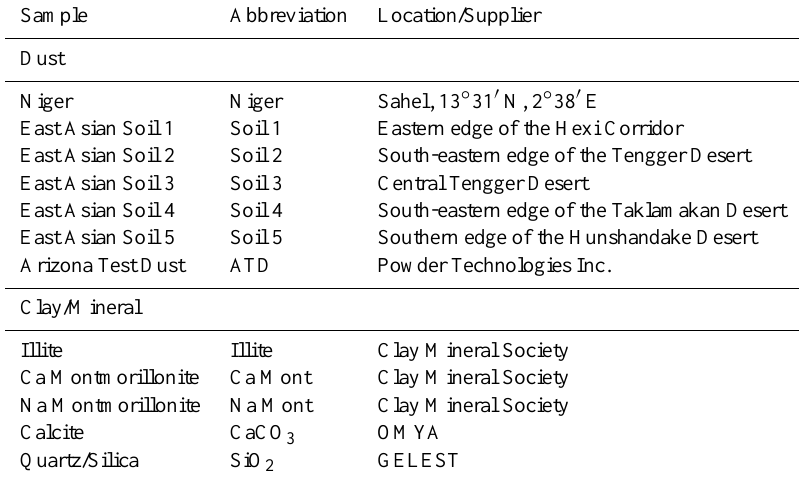
Table 1. Summary of Regional Dust Samples and Clays/Minerals analyzed in this